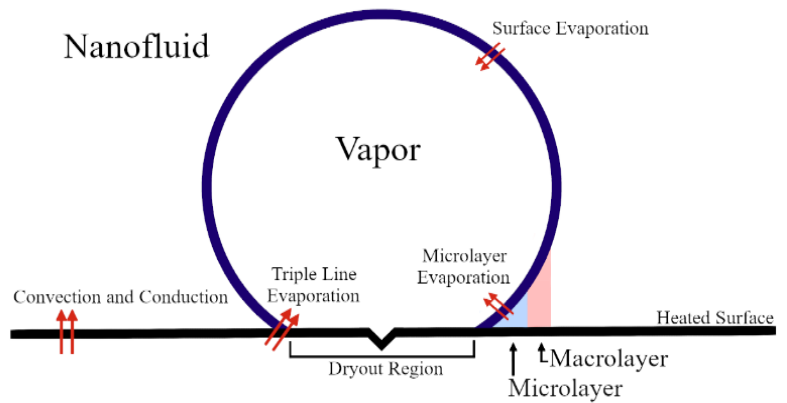
Figure 1. Bubble formation, characteristic heat transfer, and microlayer visualization. Additionally, the focus of this paper lies in the application of the TiO 2 layer for per- ovskite solar cells. Light absorption is the first step of light-to-electricity conversion in perovskite solar cells. Compounds such as methylammonium lead trihalide (CH 3 NH 3 PbX 3